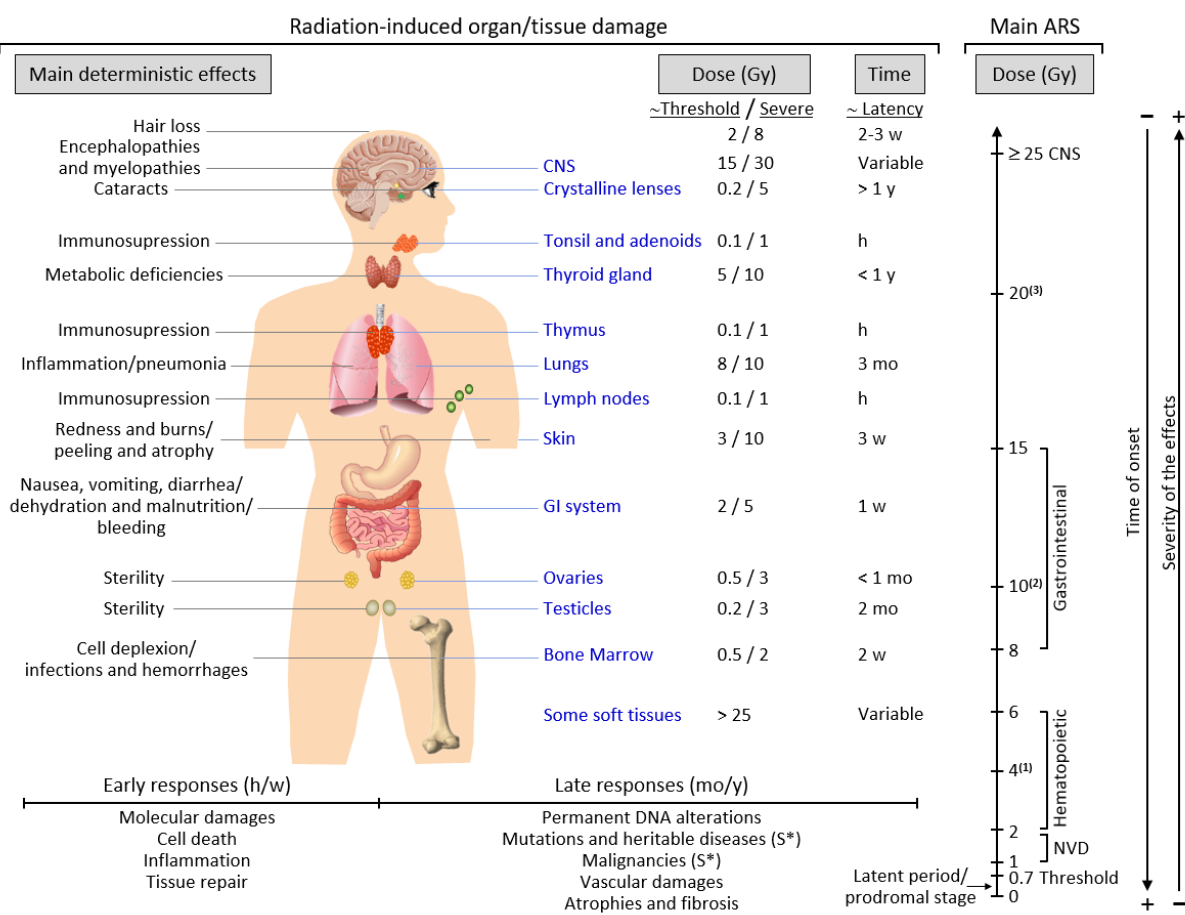
Figure 1. Consequences of exposure to ionizing radiation in organs and tissues are time- and dose-dependent. The main radiation-induced biological effects are displayed, while indicating the differences between the threshold doses and those that cause a severe effect. Time abbreviations: h, hours; w, weeks; mo, months; y, years. (S*) indicates a main stochastic effect. Acute radiation syndrome (ARS) may be difficult to differentiate from chronic radiation syndrome (CRS) since the dose threshold for the CRS is approximately 0.7–1 Gy (see the text for more details). (1) Possible death (approximately in 2 mo) due to bone marrow depletion. (2) Destruction of the intestinal lining, intestinal bleeding, possible death (1–2 w). (3) Cognitive impairment, convulsion, possible death (hours).